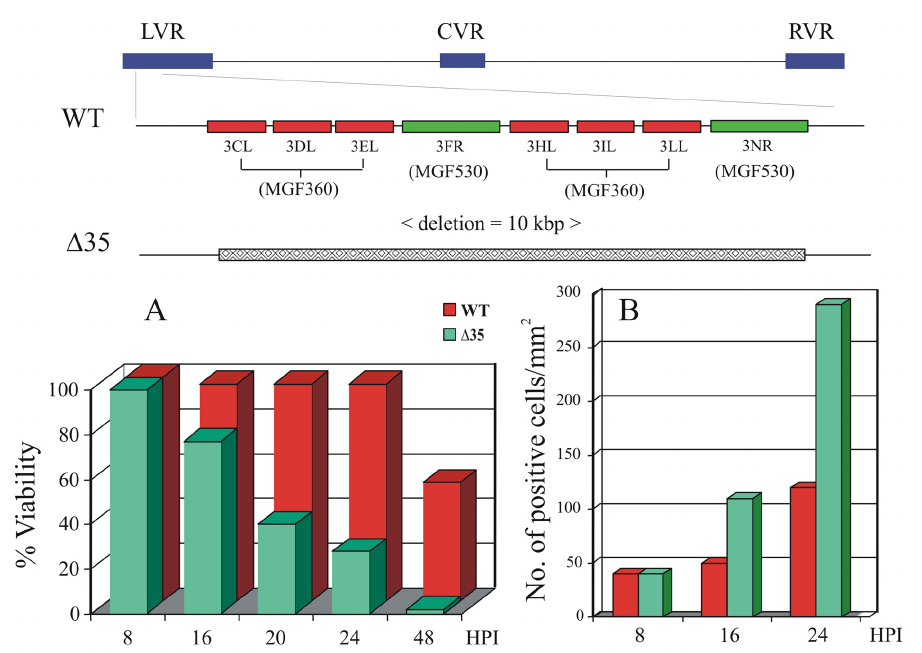
FIGURE 2 . Cell viability (A) and TUNEL assays (B) in MGF360/530 gene deletion mutant, ∆ 35-infected porcine macrophage cell cultures. Cultures were infected (MOI = 5) with wild-type (WT) or ∆ 35 viruses, and examined by trypan blue exclusion viability assay and TUNEL assay at various times postinfection. Data indicate a significant reduction in survival time, and accelerated and increased apoptotic cell death in gene deletion mutant, ∆ 35-infected macrophages (Zsak et al., unpublished